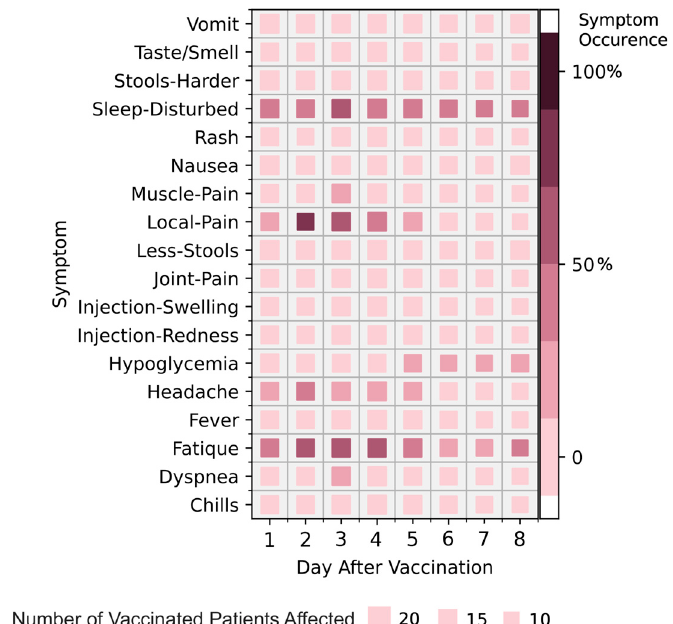
Figure 6. Symptom frequency for both monitoring periods of the 1st and 2nd vaccination combined. Symptom frequency for both monitoring periods is shown.